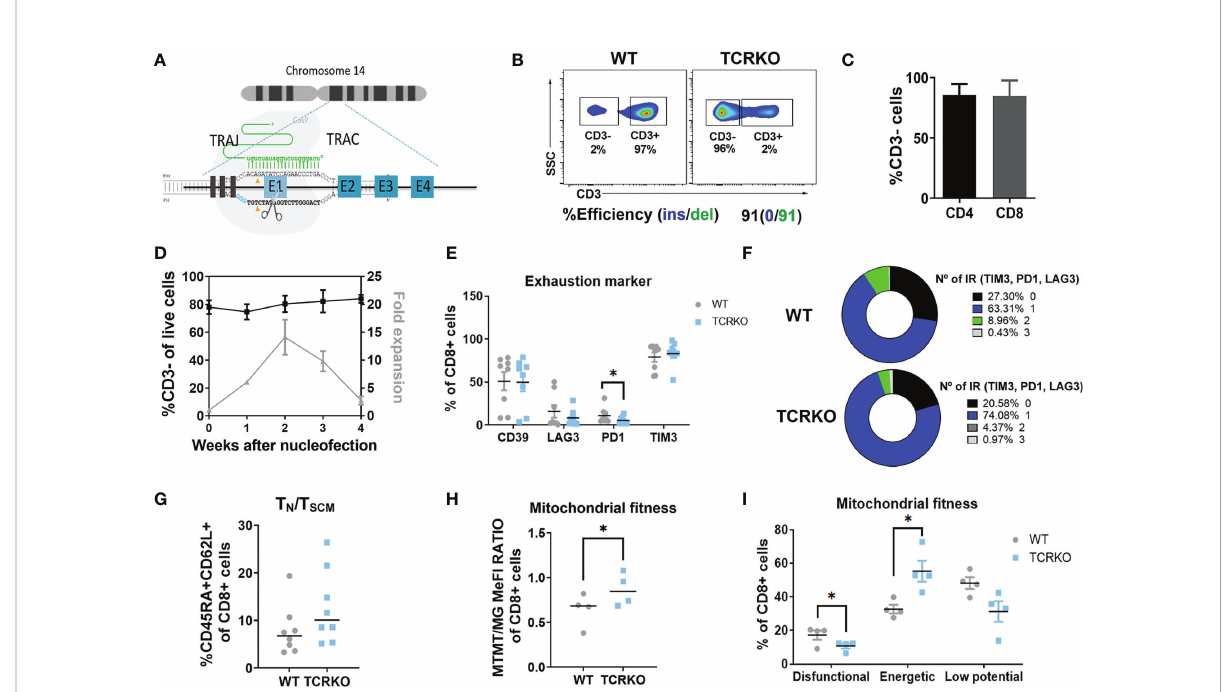
FIGURE 1 Generation of TCR negative T cells by Cas9/gRNA TCRA RNP electroporation. (A) Diagram of CRISPR/Cas9 system composed by a speci fi c gRNA against exon 1 (RNP TRAC ) of the TRAC locus and Cas9 recombinant protein. (B) Ef fi ciency of TCR disruption in primary T cells at day 3 post- nucleofection. CD3 expression by fl ow cytometry (top plots) and ICE analysis of PCR product (bottom) are shown. (C) Graph showing % of CD3- in CD4+ and CD8+ T cell populations (4 independent donors, n=8). (D) Graph showing % of CD3- of edited T cells (left Y axis) and expansion over time (right Y axis) (4 independent donors, n=4). (E) Percentage of CD39+, LAG3+, PD1+ and TIM3+ of CD8+ mock electroporated (WT) and TCRKO T cells (F) Spice graphs showing the percentage of expression of 0(black), 1(blue), 2(green) and 3(gray) exhaustion markers/inhibitory receptors (IR) (TIM3, PD1 and LAG3) in CD8+ WT (left) and TCRKO (right) T cells (G) Percentage of T N /T SCM CD8+ T cells, determined as CD45RA+CD62L+ (7 independent donors, n=8). (H) Quanti fi cation of fl ow cytometry data at day 10 post activation showing the ratio of mitochondrial membrane potential (MTRM) to mitochondrial mass (MG) in TCRKO and mock electroporated CD8+ T cells and (I) Percentage of dysfunctional(MG+TMRM-), energetic (MG+TMRM+) and low potential mitochondria(MG-TMRM-) in TCRKO and mock electroporated CD8+ T cells (WT) (4 independent donors, n=4).Statistics are based on paired, two-tailed Student´s t-test (H, I) , *p<0.05.